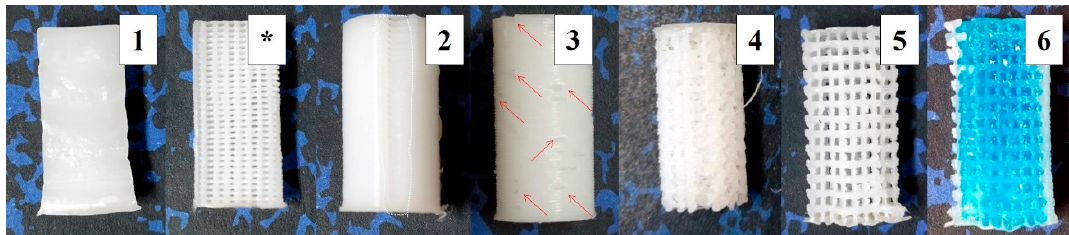
Figure 2. Pictures of the six di ff erent specimens: ( 1 ) Section of solid (100%) infill; ( * ) Section of the 30% alternated sca ff olds [2,3]; ( 2 ) Aligned seam from fixed starting point at 30% ALT with shell; ( 3 ) Random starting point appearance at 30% ALT with shell; nonaligned defects pointed out with arrows; ( 4 ) Sca ff old resulting from a slow cooling down at 30% n-ALT; ( 5 ) Forced cooling down (external fan) of 30% n-ALT; ( 6 ) 30% n-ALT filled with the hydrogel and blue colorant for a better contrast (from now 30% n-ALT + hyd). Table 1. Summary of probes configurations (specimens) and their intended features.